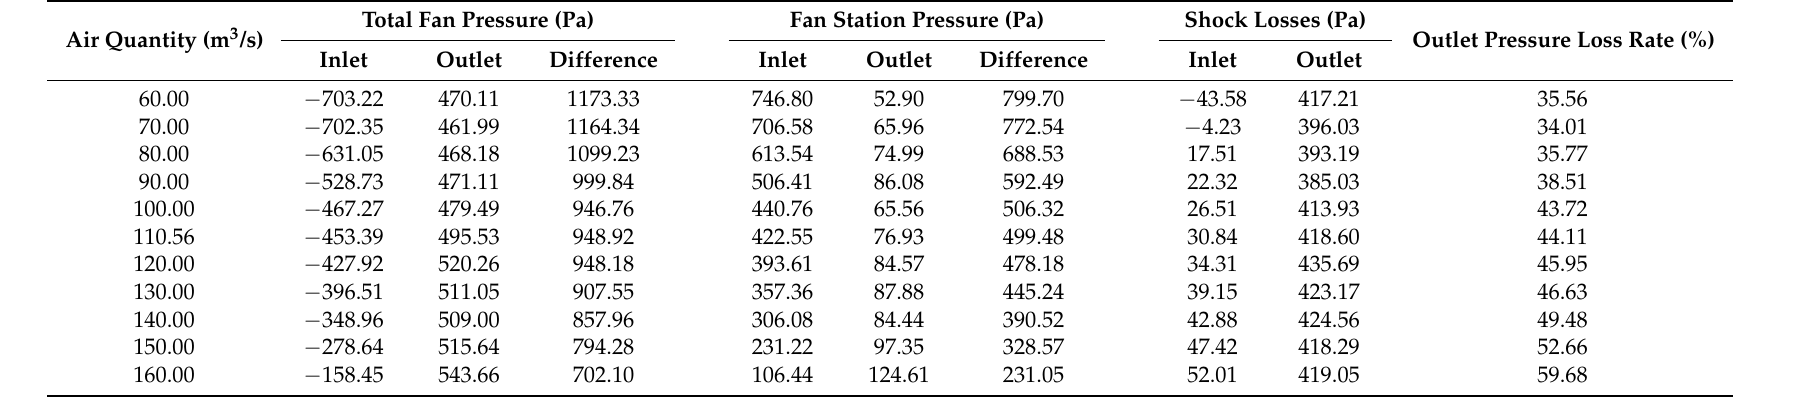
Table 2. Statistical data of air pressure in